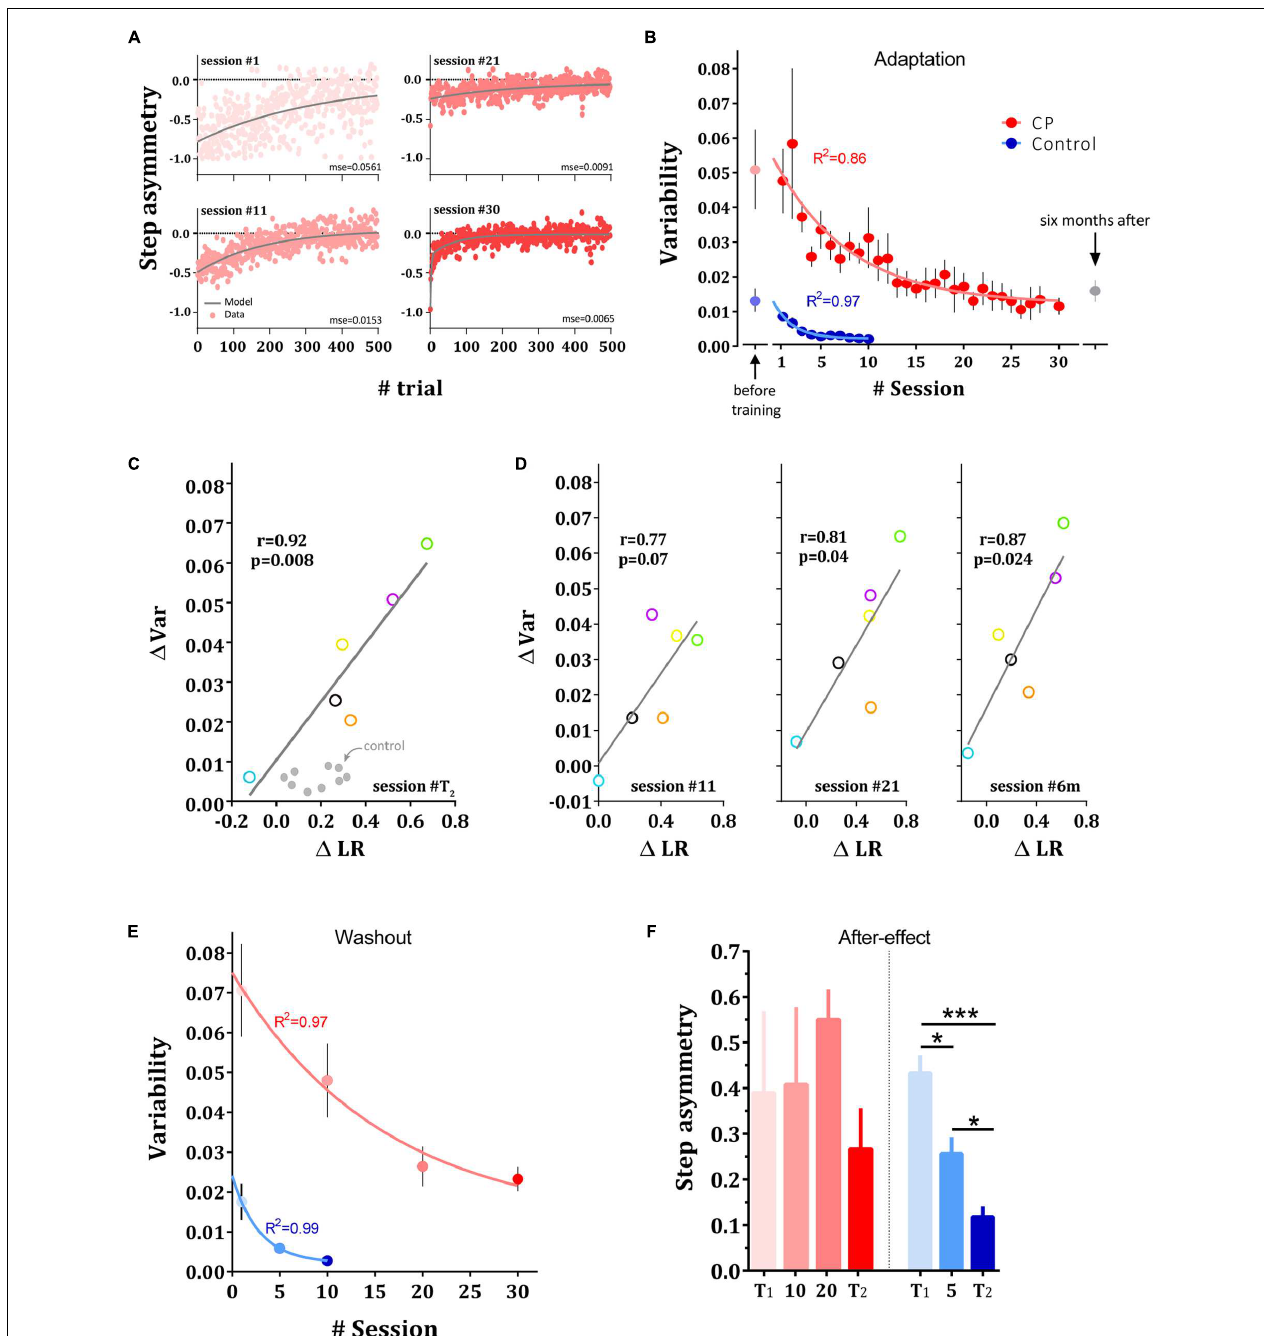
FIGURE 3 | Changes in variability in adaptation and washout sessions. (A) Reduction in variability across sessions. Experimental results and model fit. Data points are step asymmetry for representative subject from CP group in sessions 1, 11, 21, and 30. Gray line is the fit for the dual-exponential function. MSE for each session is presented bellow each curve. (B) Changes in variability averaged across adaptation sessions in control (blue dots) and CP group (red dots). Faint dots represent the variability during the first baseline session prior to the training. Curves represent the single exponential fit to the mean data for each group, respectively. Gray point represents the execution variability in CP 6 months after the adaptation sessions. (C) Inter-subject correlation between the improvements in the estimated learning rate ( (cid:49) LR) and the reduction in variability ( (cid:49) Var) in CP subjects when comparing T 2 with T 1 . (D) Correlation between change on learning rate and reduction in variability after 11 sessions (left panel), 21 sessions (middle panel) and 6 months after training (right panel). (E) Changes in variance across washout sessions in control (blue dots) and CP group (red dots). Curves represent the single exponential fit to the mean data for each group, respectively. (F) After-effect in the washout sessions in both groups. Bars show the mean across subjects and error bars represent standard error of means ( ± SE). Significance levels is depicted by asterisks – ∗ p < 0.05, ∗∗∗ p < 0.001.